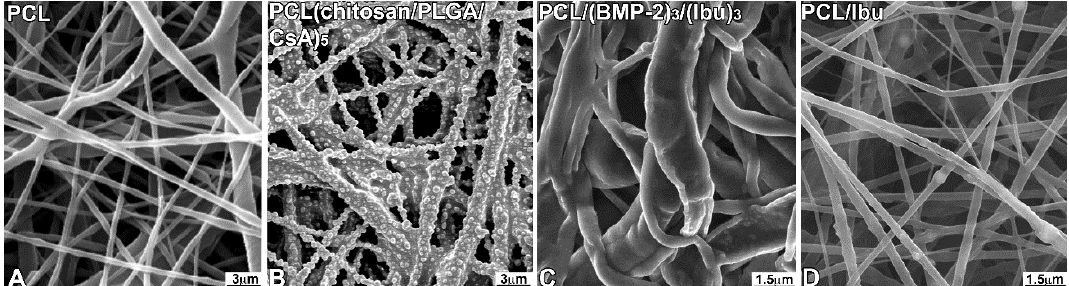
Figure 1. Scanning electron microscopy (SEM) observations of non ‐ functionalized PCL scaffolds consisting of non ‐ woven electrospun nanofibers ( A ), PCL scaffolds grafted with CsA ‐ loaded PLGA nanoparticles (chitosan/PLGA/CsA) 5 ( B ), with BMP ‐ 2/Ibuprofen (PCL/(BMP ‐ 2) 3 /(Ibu) 3 ) nanoreservoirs ( C ) or with Ibuprofen ( D ). For the morphological study by SEM, the different scaffolds were fixed with 4% paraformaldehyde, dehydrated in successive baths of ethanol (25, 50, 75, 90, 100%) and treated with hexamethyldisilazane (HDMS). They were mounted on a supporting sample holder using carbon conductive adhesive, then, silver ‐ coated and observed with a Philips XL ‐ 30 ESEM scanning electron microscope in conventional mode (high vacuum) with a Everhart ‐ Thornley secondary electron detector.